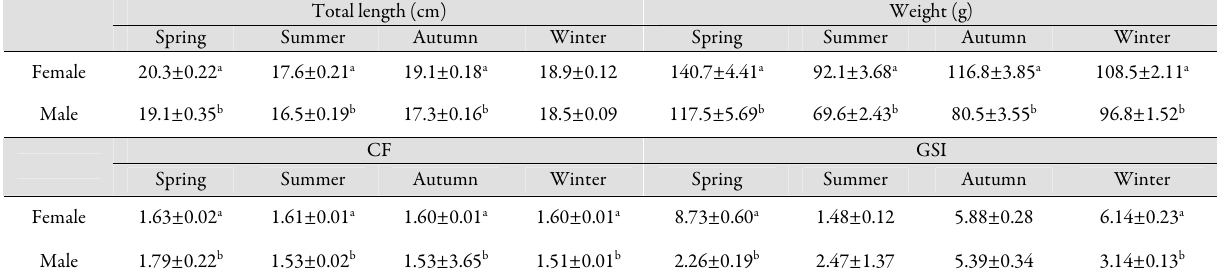
Table 5. Statistical analyses of C. gibelio individuals between sexes